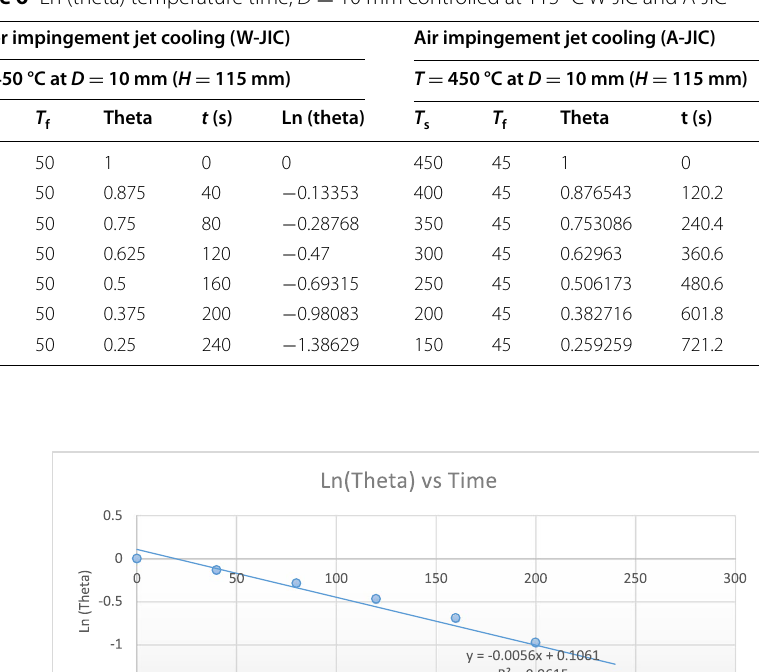
10 mm controlled at 115 °C W-JIC and A-JIC =